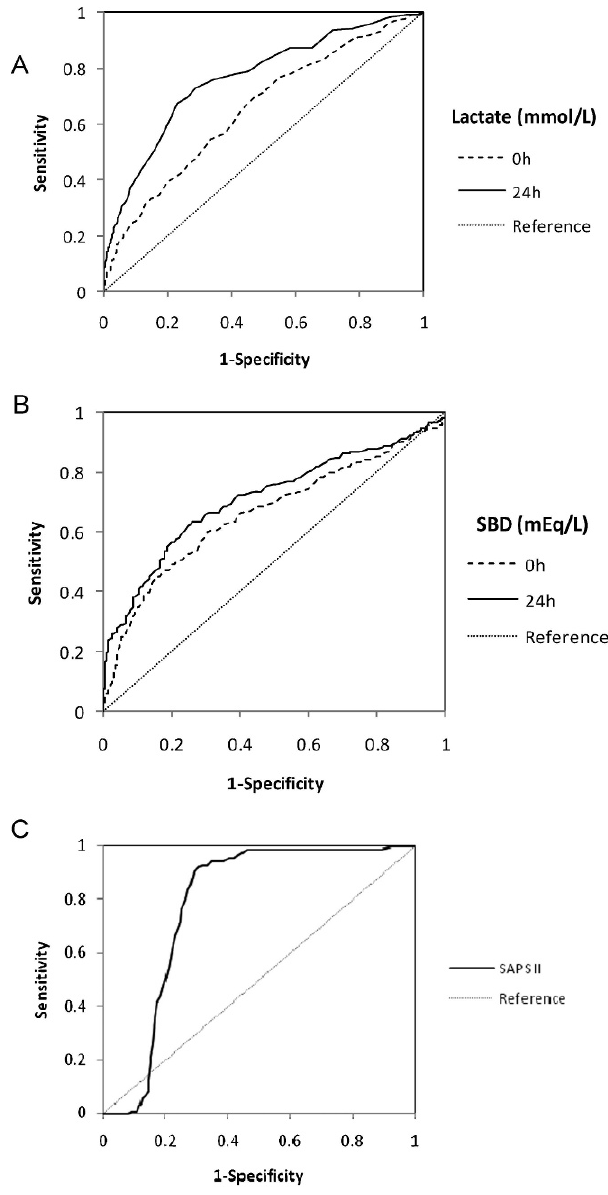
Figure 2 - Receiver Operating Characteristic (ROC) curve comparing the ability of A) lactate (mmol/L), B) standard base deficit (SBD in mmol/L) at baseline and after 24 and C) SAPS II SCORE after 24h in predicting ICU mortality.